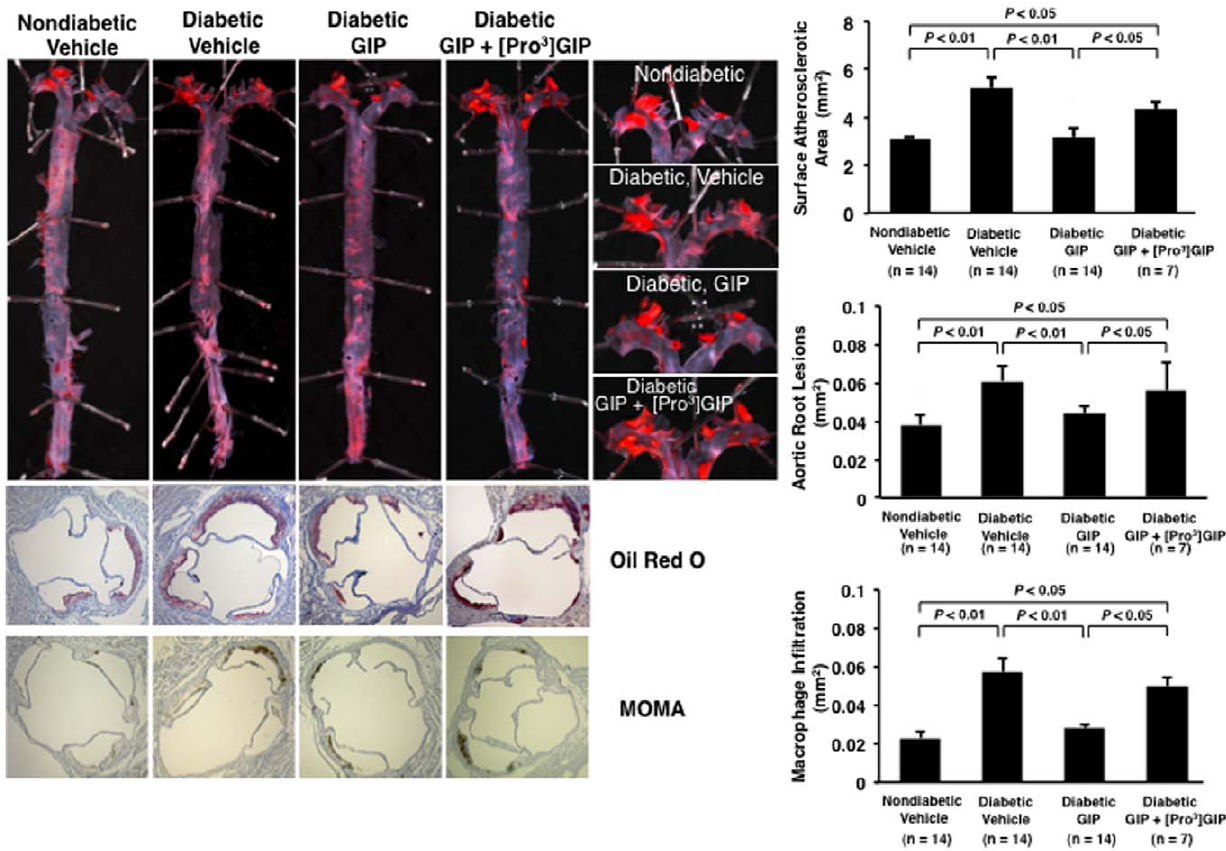
Figure 1. Suppressive effects of GIP on the progression of atherosclerotic lesions in diabetic Apoe 2 / 2 mice. Thirty-five mice at 15 weeks of age were made diabetes by peritoneal injection of STZ (50 mg/kg/day) for 5 days and 14 mice were untreated. The 17-week-old diabetic Apoe 2 / 2 mice were infused for 4 weeks with vehicle (control), GIP (25 nmol/kg/day), or GIP + [Pro 3 ]GIP (both 25 nmol/kg/day) by osmotic mini-pumps. The aortic surface was stained with oil red O. Cross-sections of the aortic root were stained with oil red O or anti-MOMA-2 antibody. Hematoxylin was used for nuclear staining. The areas occupied by atherosclerotic lesions and by macrophage infiltration in the aortic wall were determined.